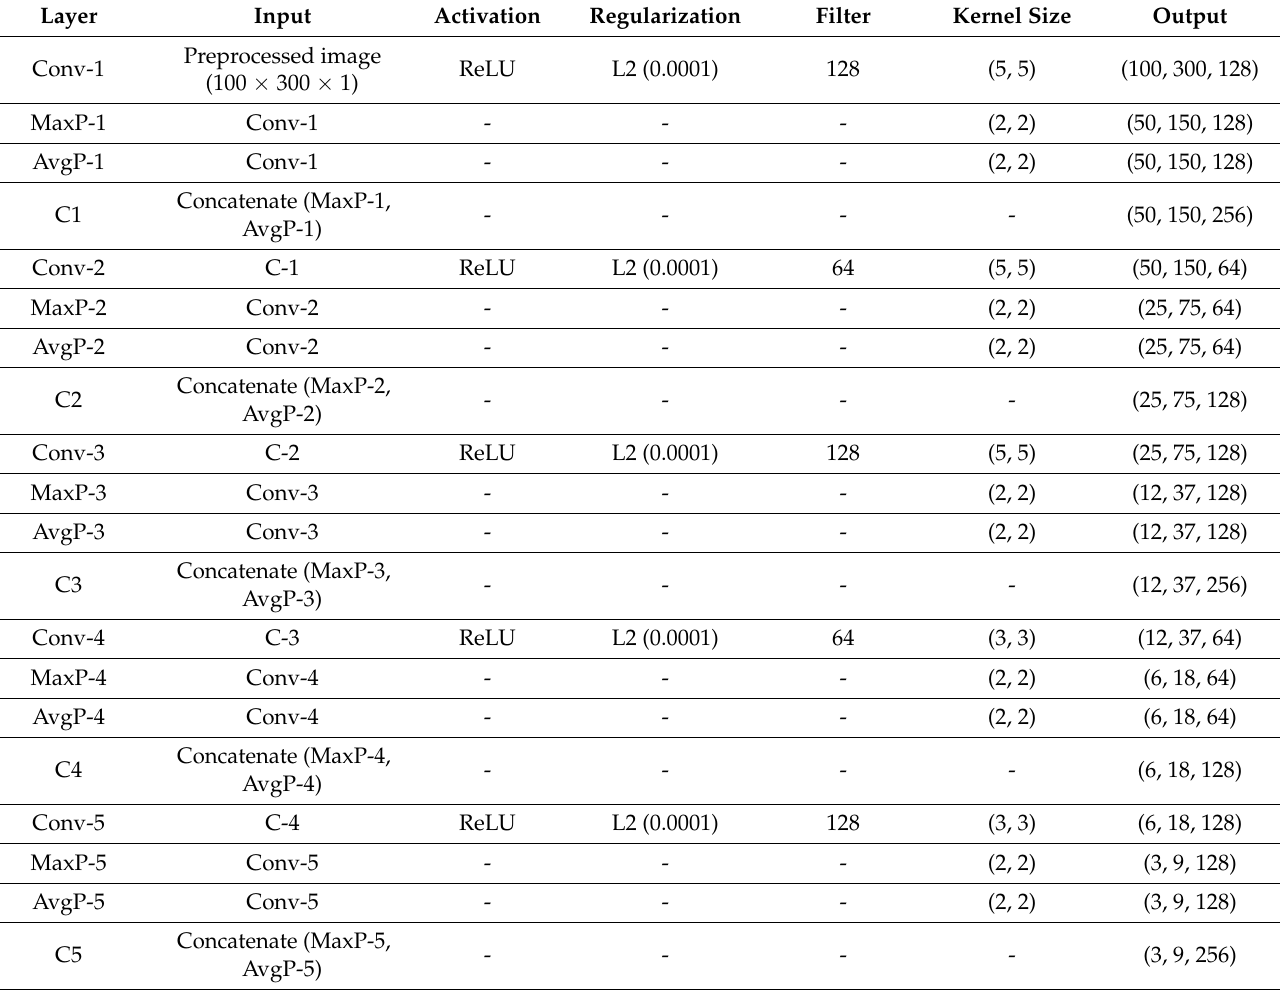
Table 1. Detailed Network Hyperparameters of the Feature Extraction Procedure. The abbrevi- ational terminologies in the table are: Conv: Convolution, MaxP: Maxpool, AvgP: Averagepool, C: